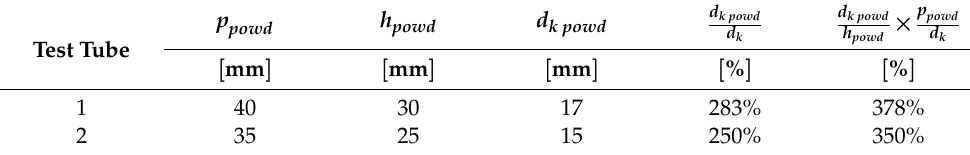
Table 5. Depth measures related to neutralization assays of drilling powder.